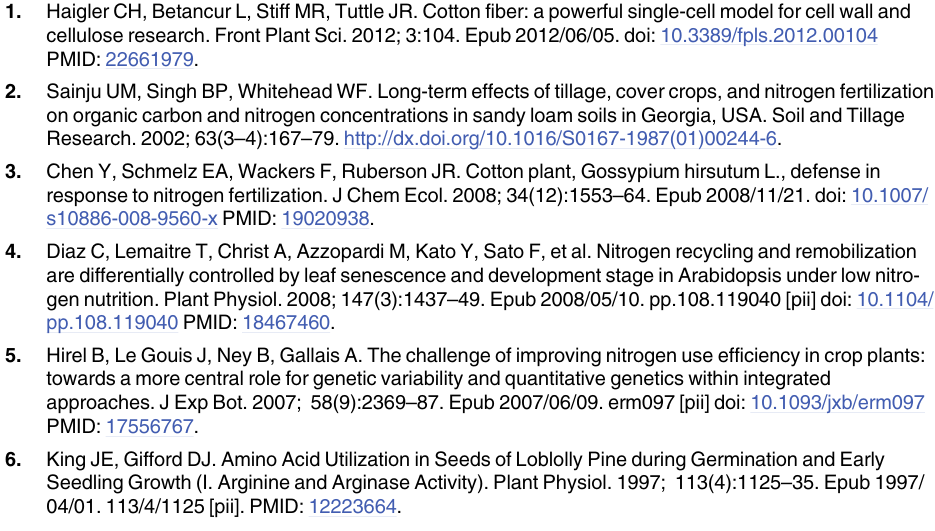
S1 Fig. Morphology of transgenic cotton seedlings grown on 1/2 strength MS media con- taining varying nitrogen content.